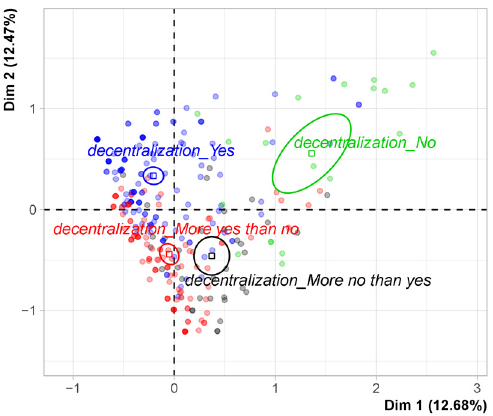
Figure A6. MCA. Distribution of respondents by attitudes towards increased decentralization.